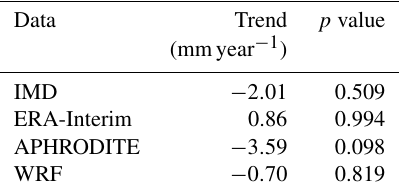
Table A1. Statistics of the non-parametric Mann–Kendall test of